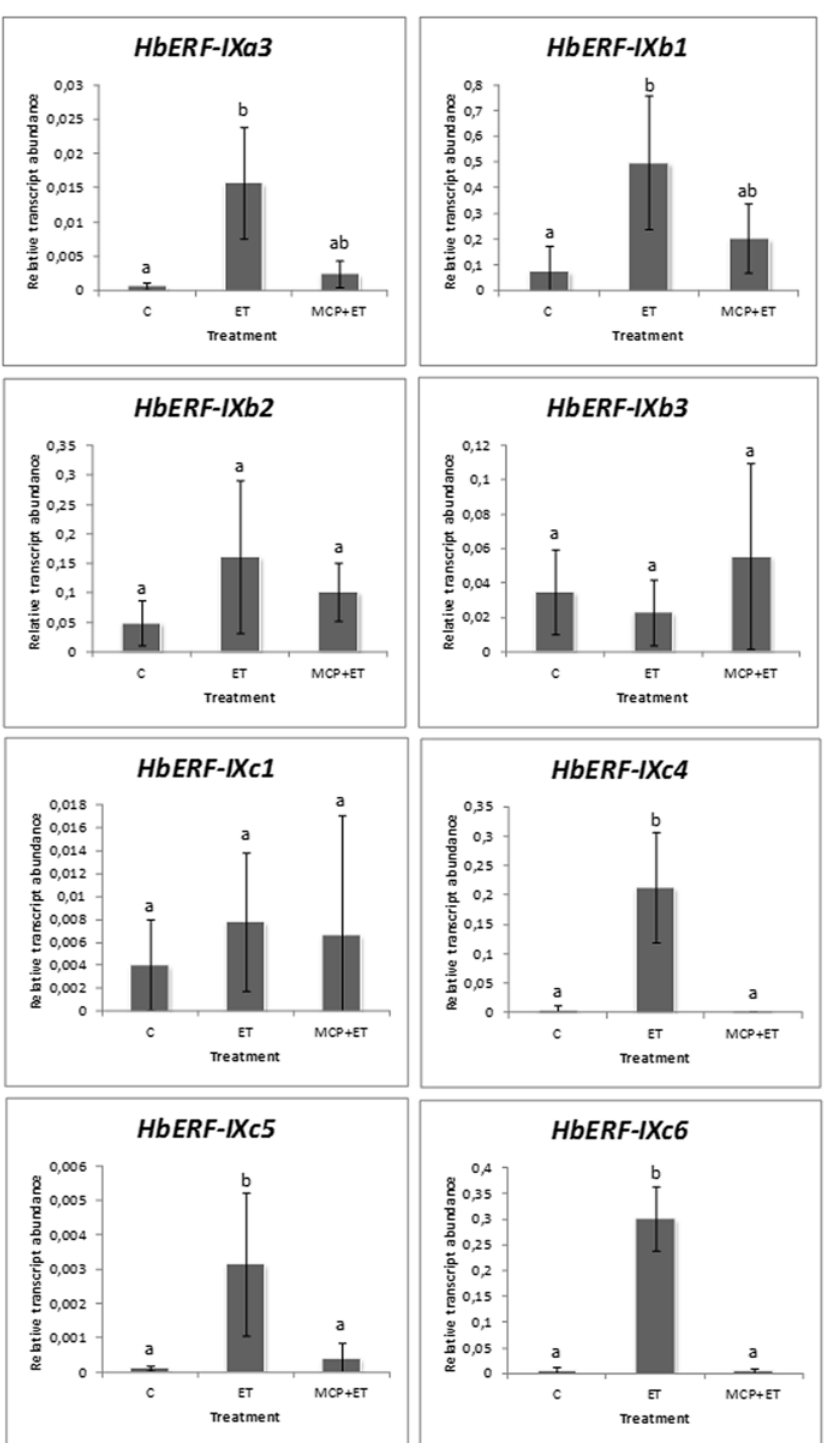
Fig 7. Effect of 1-MCP treatment on the relative transcript abundance of 8 genes of Hevea brasiliensis ERF group IX.